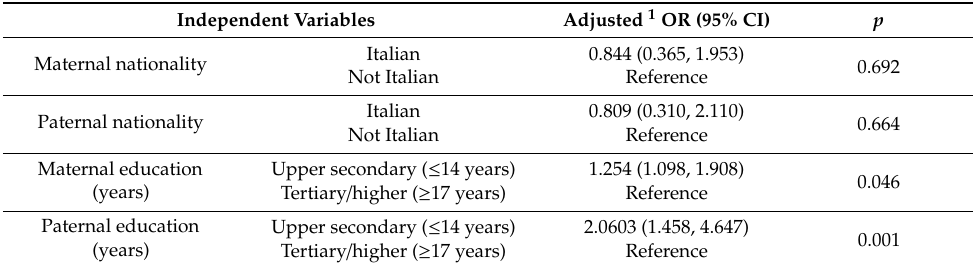
Table 2. Logistic regression analysis of parental nationality and educational level associated with Environmental Tobacco Smoke (ETS) exposure among monitored schoolchildren.